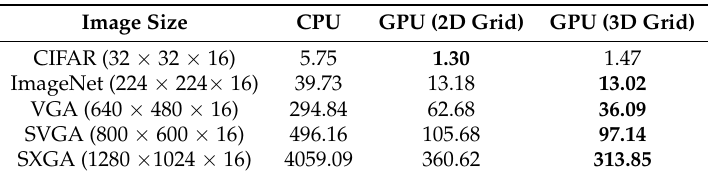
Table 5. Execution time of rectifier linear layers under various computational loads (ms), best results are written in bold.